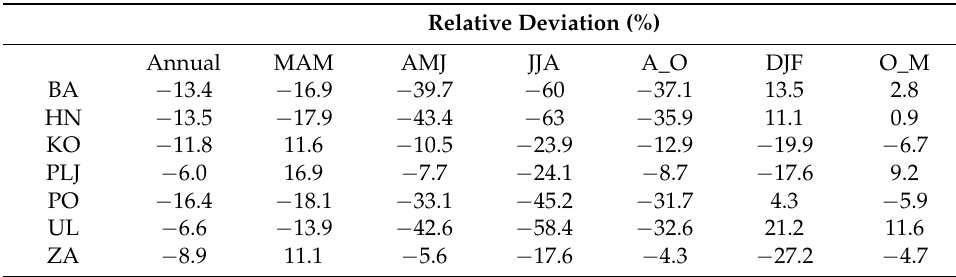
Table 4. The relative deviation (%) of average annual precipitation for the 2071–2100 climate in respect to referent climatology